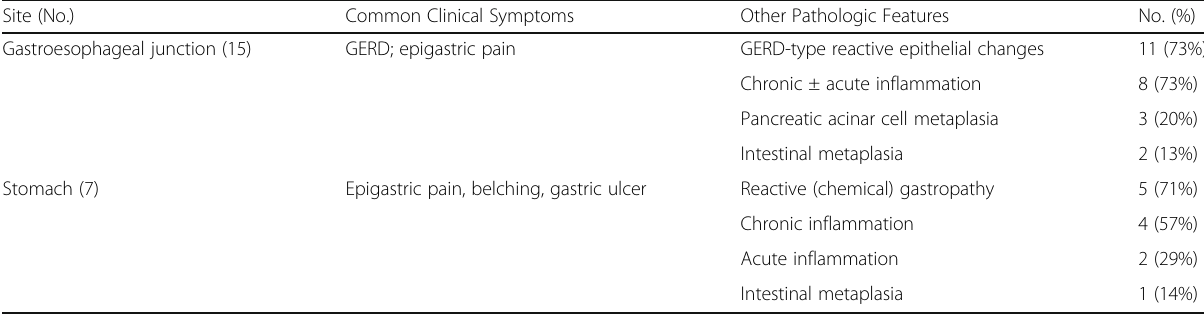
Table 2 Summary of Clinicopathologic Features of Gastroesophageal Specimens with Multinucleated Stromal Giant Cells Site (No.)